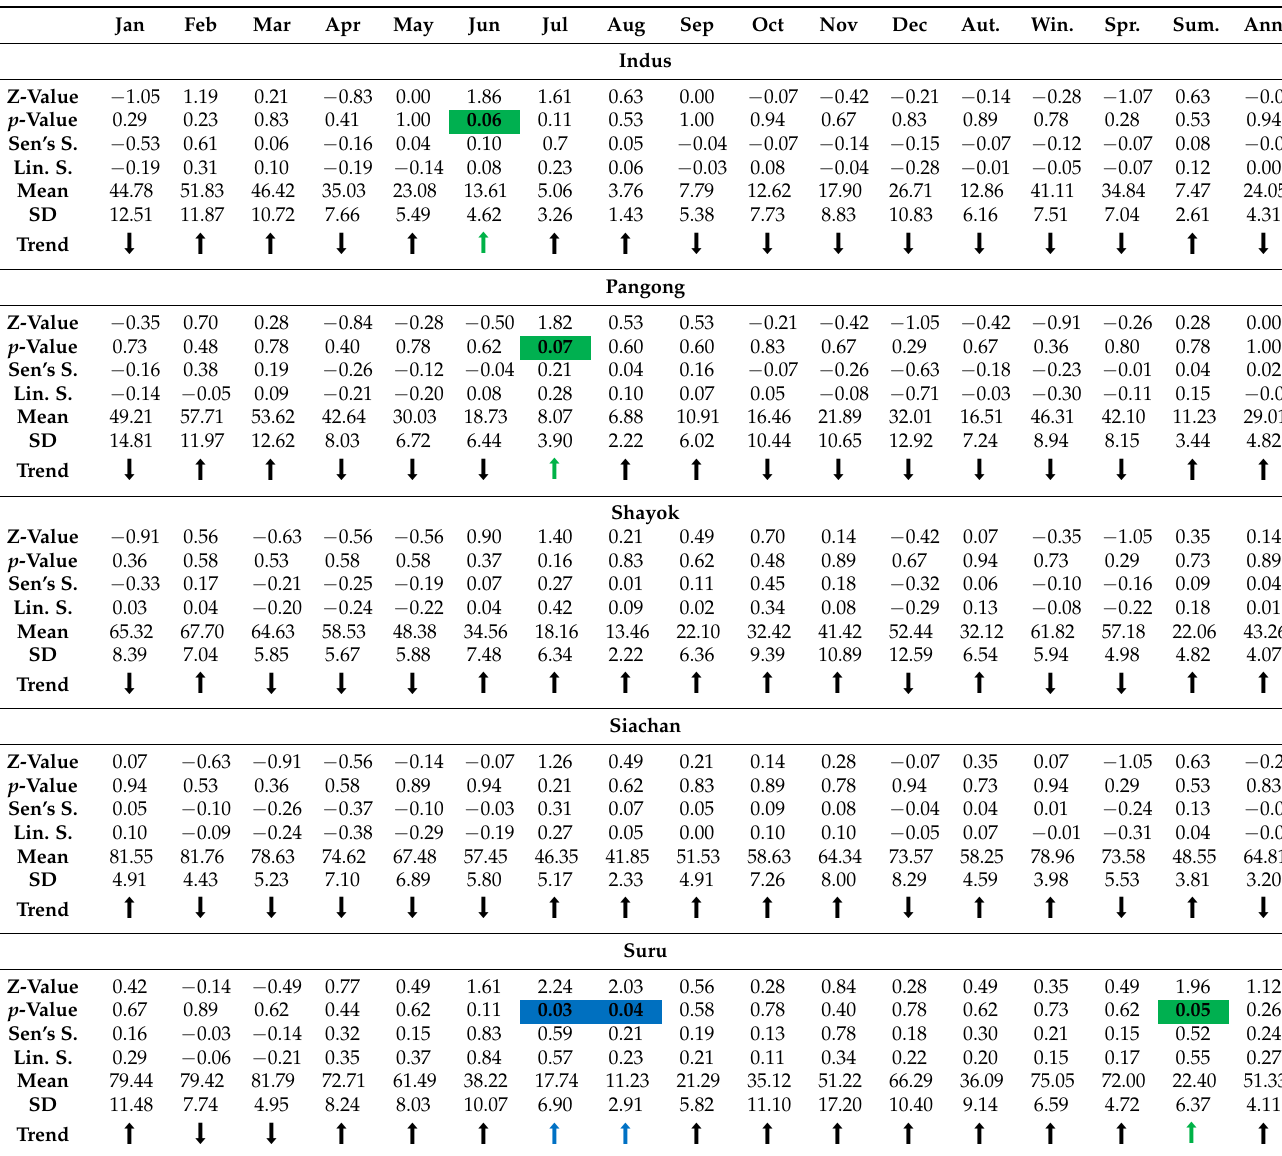
Numbers in bold and blue: significance level, p -value < 0.05.